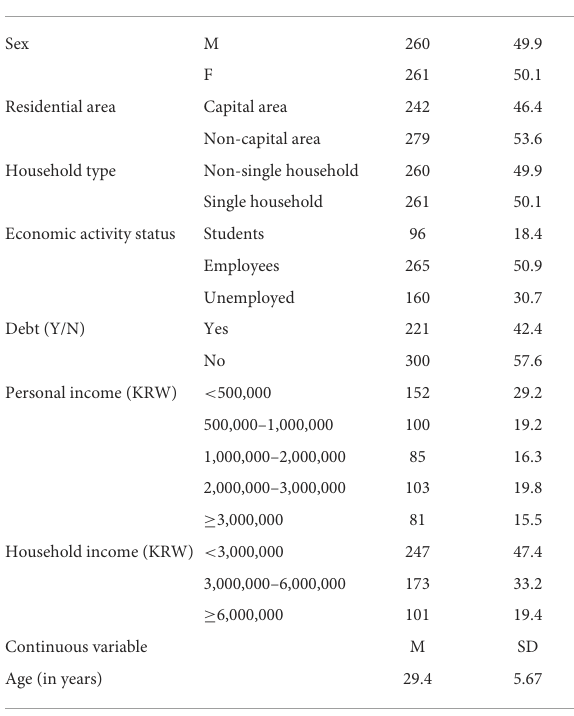
TABLE 1 Participants’ sociodemographic characteristics ( N =